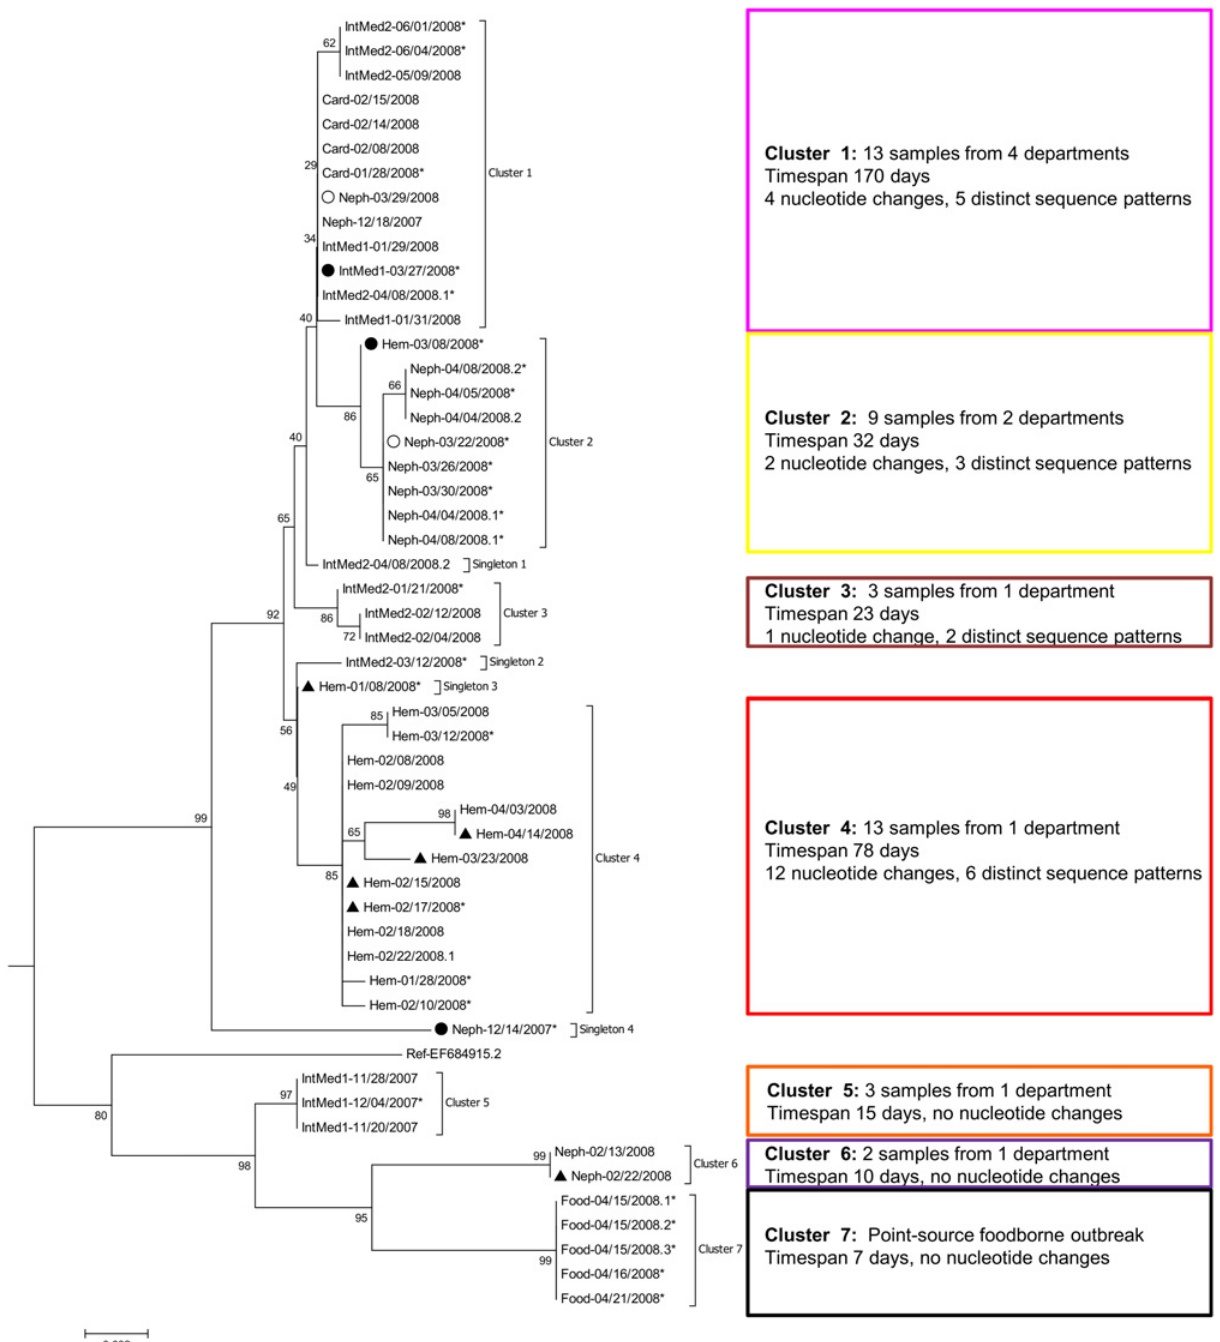
Figure 1. Phylogenetic tree of 53 NoV genotype II.4 variant Den Haag 2006b capsid sequences. All capsid sequences (first sample per patient) were aligned and a Neighbor Joining tree was constructed and rooted on the branch between the Den Haag 2006b variant and the Osaka 2007 and Apeldoorn 2007 sequences. The subtree of the 2006b variant is displayed here. Sites with mixed bases were ignored for phylogenetic analysis. Sequence names represent hospital department (Hem: hematology, Neph: nephrology, IntMed1/2: internal medicine 1/2, Card: cardiology, Food: foodborne outbreak) and date of sampling (mm/dd/yyyy), eventually followed by a serial number to ensure uniqueness. Sequences from patients with symptom onset within 48 hours after hospital admission are marked with a circle (filled circle: no previous contact to hospital, empty circle: frequent contact to hospital due to hemodialysis). Sequences from the first samples from six patients with persistent diarrhea are marked with a filled triangle. Sequences from samples with an available polymerase gene sequence from previous genotyping (n = 27) are marked with asterisks and phylogenetic analysis of this subgroup is shown in Fig. 4. On the right hand side of the tree epidemiological information is given as well as numbers of nucleotide changes within the cluster and the number of distinct sequence patterns included in the cluster. doi:10.1371/journal.pone.0115331.g001 PLOS ONE | DOI:10.1371/journal.pone.0115331 January 15,